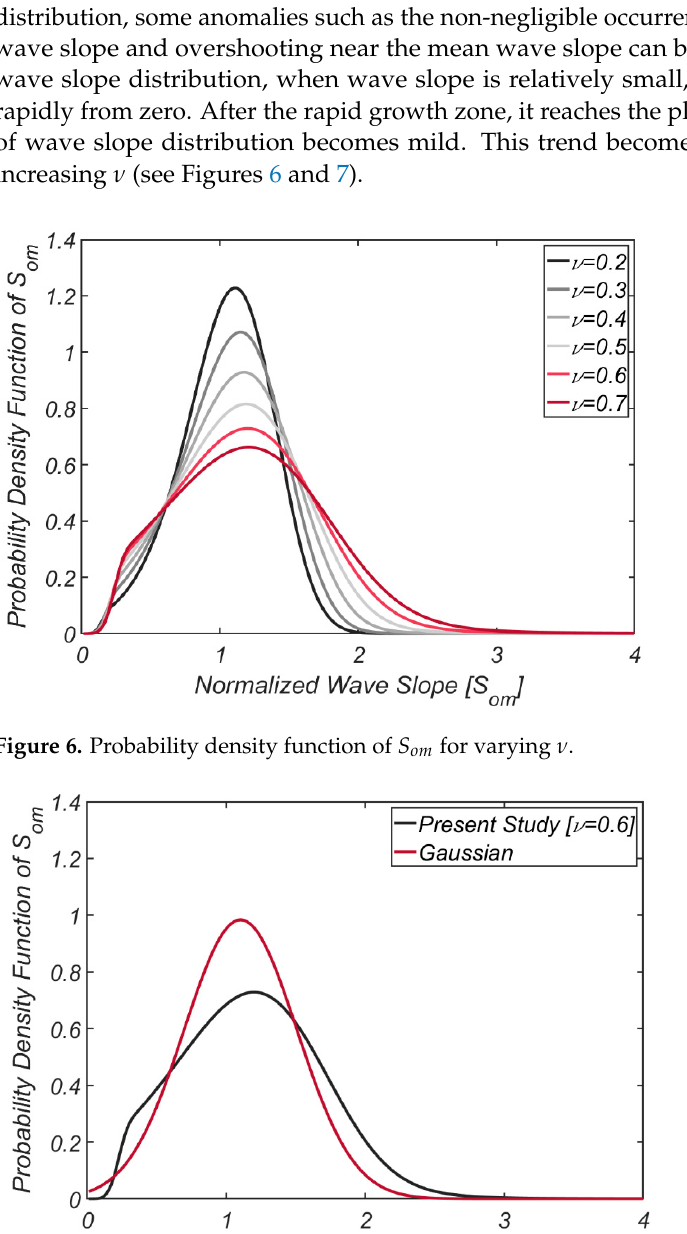
Figure 7. Comparison of